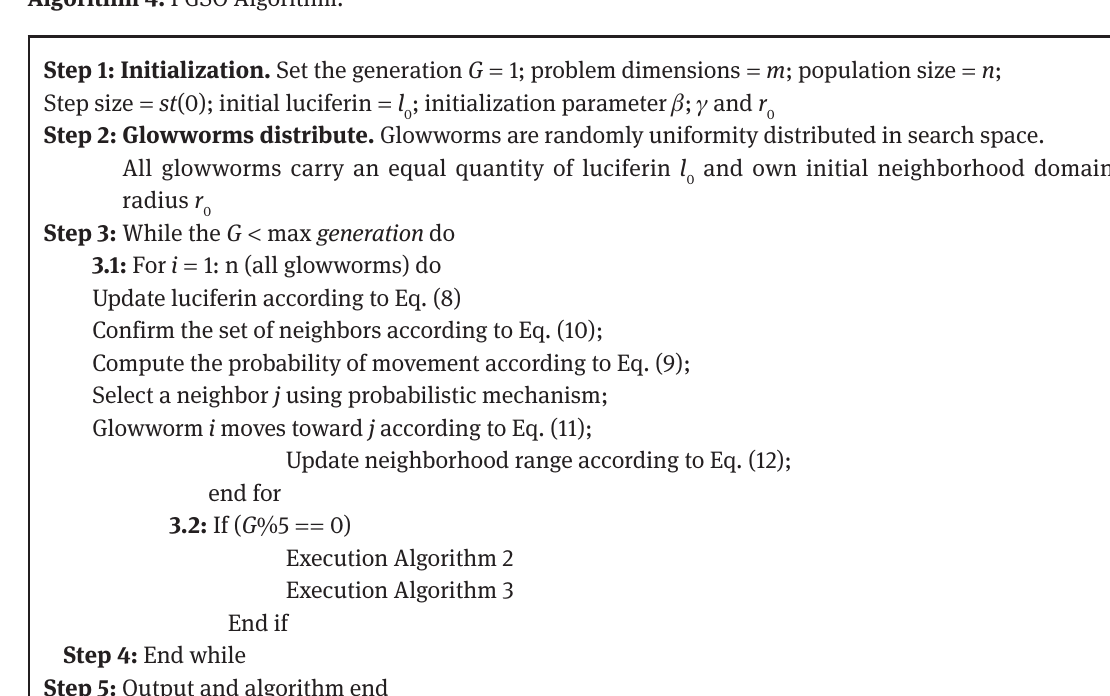
Algorithm 4. PGSO